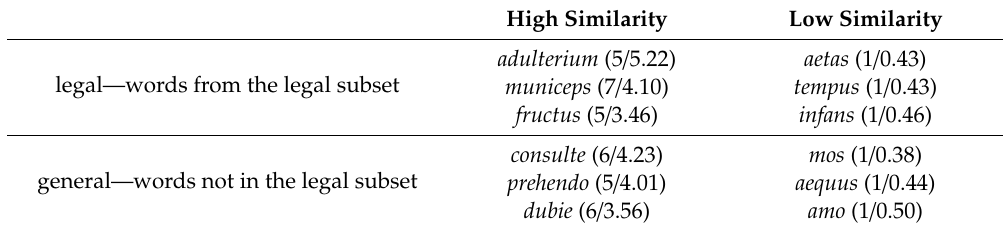
Table 3. Words selected for comparison from the evaluation benchmark and its legal subset in the LatinISE and ROMTEXT corpora; the two columns show the number of overlapping items in their top 10 semantic neighbours and the corresponding weighted similarity score shown in brackets, one indicating high similarity, the other indicating low